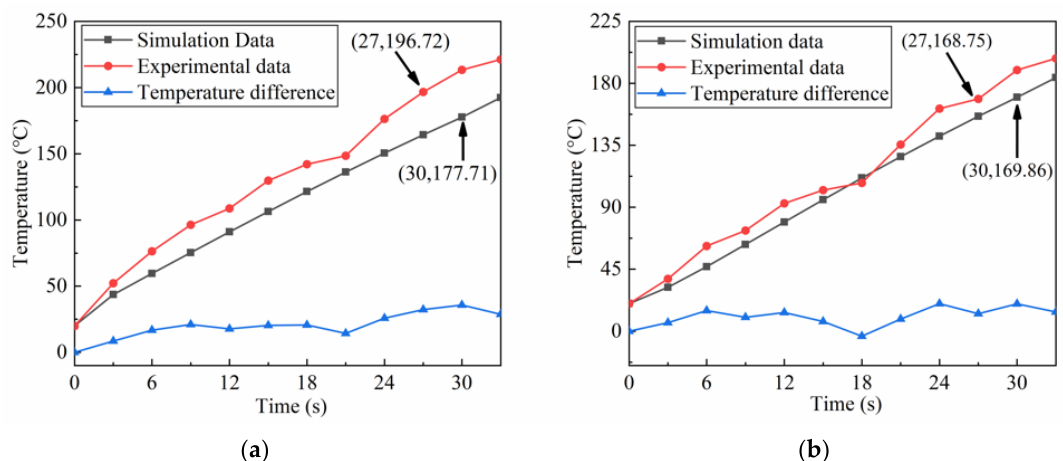
Figure 19. Comparison of the experimental and simulated temperatures: ( a ) tooth top point A; ( b ) tooth root point B.